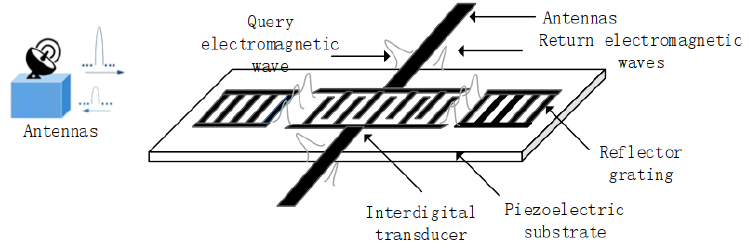
Figure 1. Wireless and passive SAW (surface acoustic wave) sensor systems employing a one-port resonator.